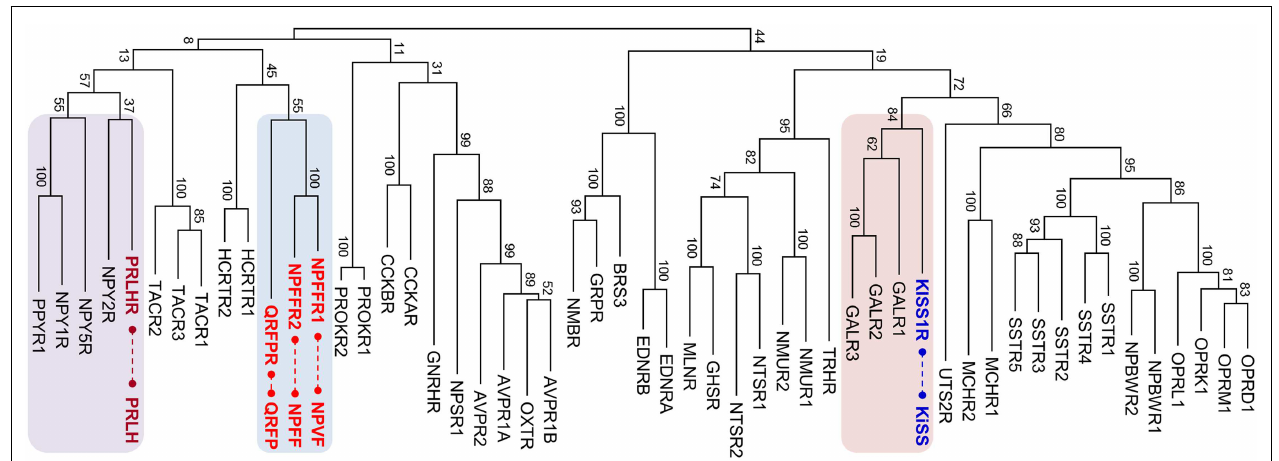
prolactin-releasing hormone receptor; NPYR, neuropeptideY receptor; PROKR, prokineticin receptor;TACR, tachykinin receptor; CCKR, cholecystokinin receptor; HCRTR, hypocretin (orexin) receptor; QRFPR, pyroglutamylated RFamide peptide receptor; NPFFR, neuropeptide FF receptor; AVPR, arginine vasopressin receptor; OXTR, oxytocin receptor; NPSR, neuropeptide S receptor; GnRHR, gonadotropin-releasing hormone receptor; UTSR, urotensin receptor; GALR, galanin receptor; KISSR, kisspeptin receptor; MCHR, melanin-concentrating hormone receptor; SSTR, somatostatin receptor; NPBWR, neuropeptides B/W receptor; OPR, opioid